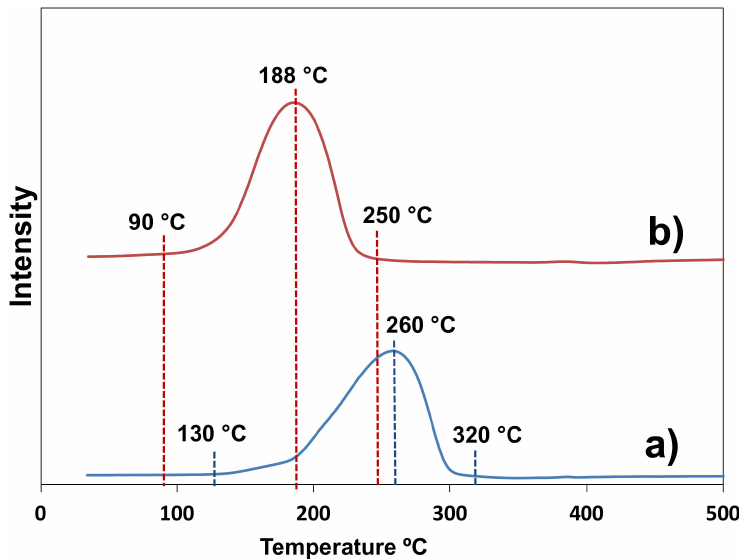
Figure 1. TPR profiles for the calcined catalysts: ( a ) Cu/MgO/Al 2 O 3 ; ( b ) 2Pd/Cu/MgO/Al 2 O 3 . Cu/Mg/Al (molar) =